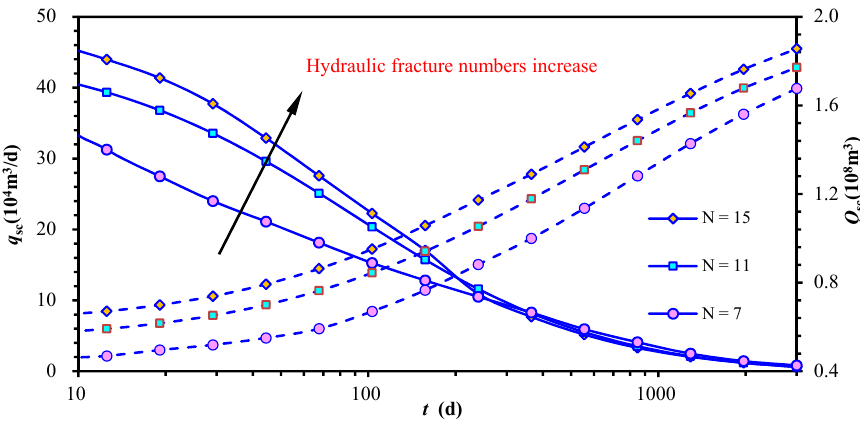
Figure 13. Effect of hydraulic fracture numbers increase on production of a MFHW in shale.